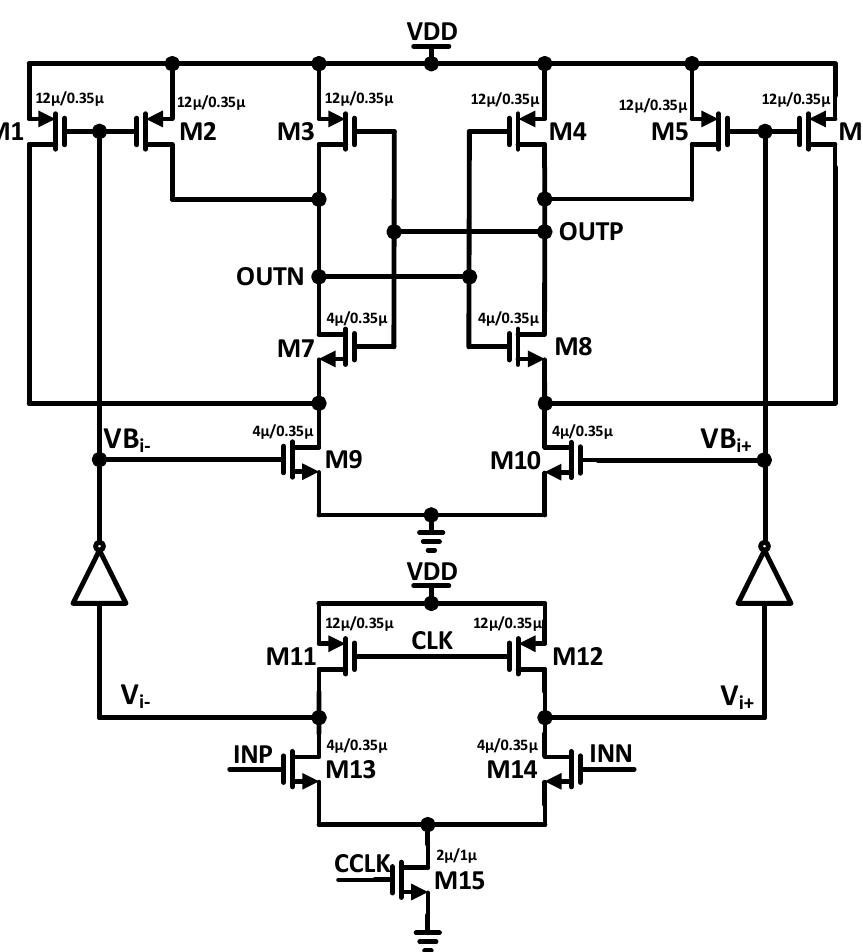
Figure 7. Transistor-level schematic of the dynamic comparator. In the evaluation phase, when the clock signal CCLK increases, the V i nodes dis- charge to VSS depending on the input voltage through the input transistors M13 and M14, and the tail transistor M15. The VB i nodes are charged from VSS to VDD, while the V i nodes are discharged to VSS in the evaluation phase. Other transistors will be turned on when the NMOS transistors M9 and M10 are turned on in the second stage and either of the VBi nodes reaches the threshold voltage V th . Consequently, the latch is activated and regenerates the digital voltage at the output.